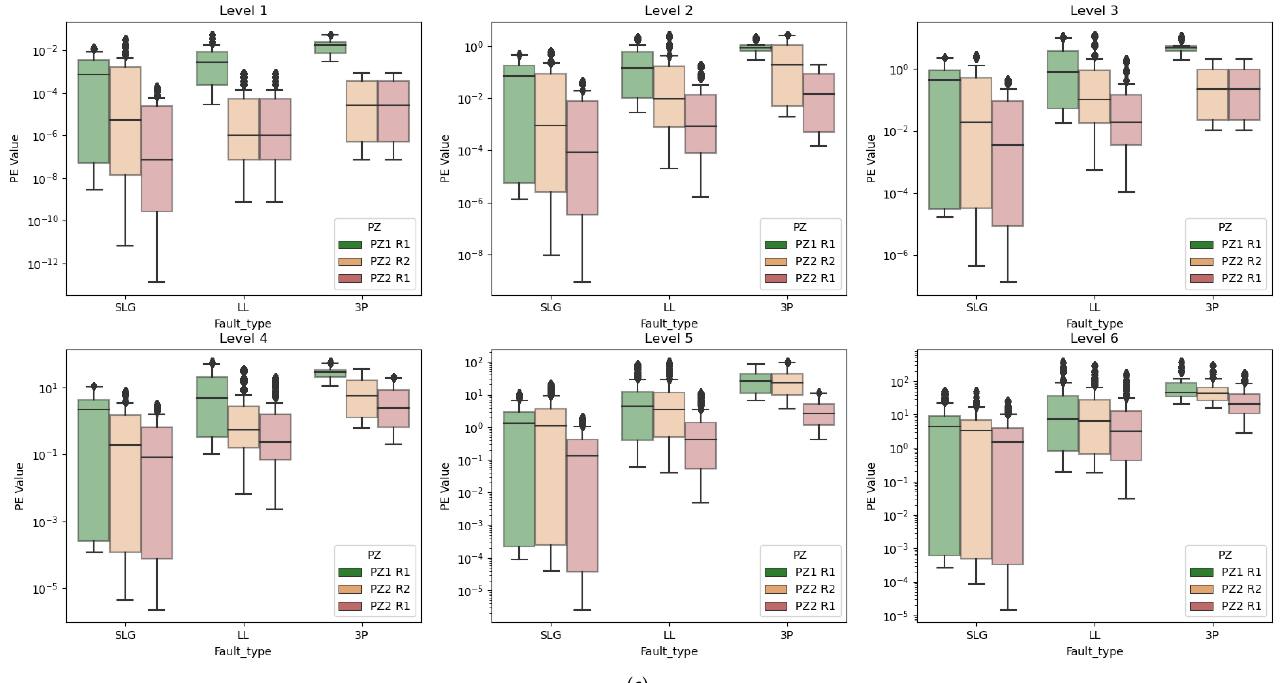
Figure 7. PE values per level by fault type and decomposition mode. ( a ) Ground mode. ( b ) Aerial 1 mode. ( c ) Aerial 2